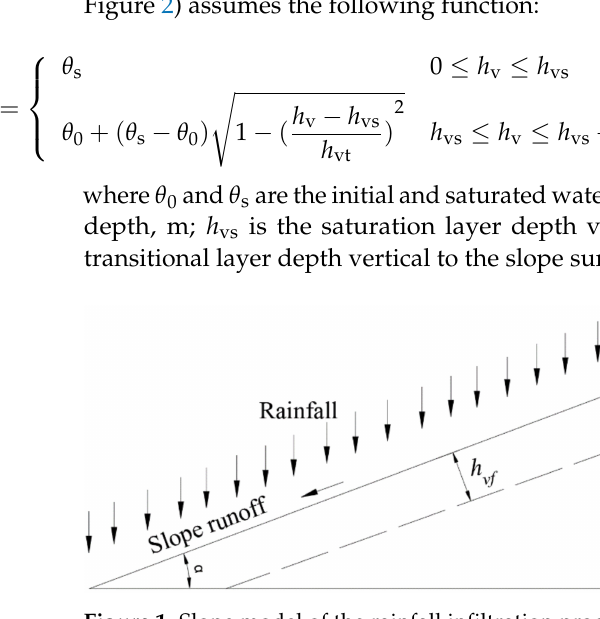
Figure 1. Slope model of the rainfall infiltration